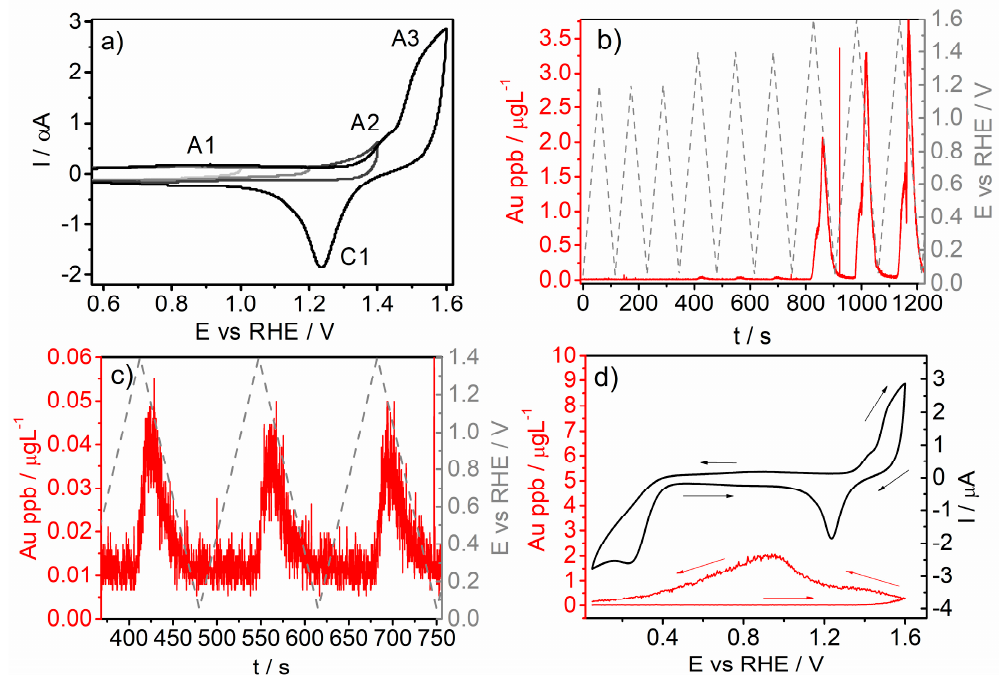
Figure 2. ( a ) Cyclovoltammetric (20 mV · s − 1 ) response of Au polycrystalline disc by gradually increasing the upper potential limit for 200 mV from 1 V to 1.6 V RHE in 0.05 M H 2 SO 4 in a conventional three-electrode cell; ( b , c ) Electrochemical flow cell coupled to inductively coupled plasma mass spectrometry (EFC-ICP-MS) measurements of Au dissolution from Au polycrystalline disc during potentiodynamic cycles (20 mV · s − 1 , 0.05–1.4 or 1.6 V RHE ) in 0.05 M H 2 SO 4 ; ( d ) Simultaneous presentation of Au dissolution profile and current signal during the potentiodynamic cycle (20 mV · s − 1 , 0.05–1.6 V RHE ).